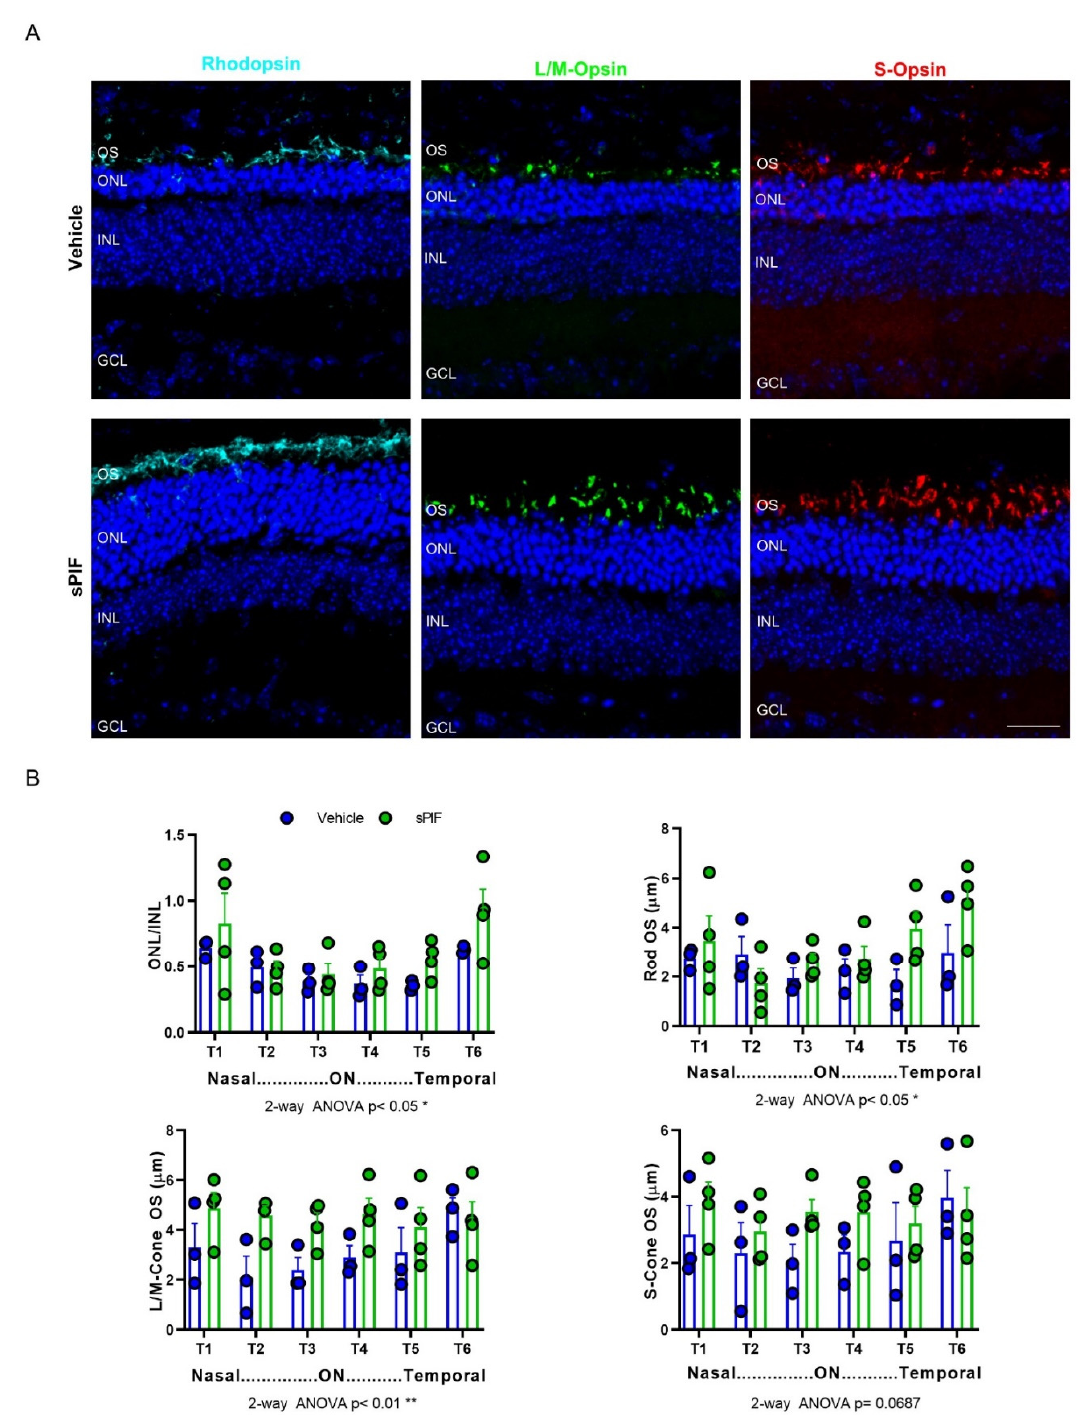
Figure 6. Effect of sPIF treatment on photoreceptor preservation in rd10 mice. Animals received daily intraperitoneal injections of vehicle or sPIF from P15 to P27. Retinas were analyzed at P29, after ERG had been performed. ( A ) Representative images of central retinal areas in cryosections immunostained for rhodopsin (cyan), L/M-opsin (green), and S-opsin (red). Nuclei were stained with DAPI (blue). ONL, outer nuclear layer; INL, inner nuclear layer, GCL, ganglion cell layer. Scale bar, 22 µ m. ( B ) ONL and INL thickness and the length of rod and cone outer segments were measured in equatorial sections corresponding to 6 regions of the retina, following a nasotemporal sequence (T1–T6). Plots show the mean + SEM. n = 3–4 mice, 2–3 sections per retina, 3 measurements per region and section. ON, optic nerve. ** p < 0.01; * p < 0.05 (2-way